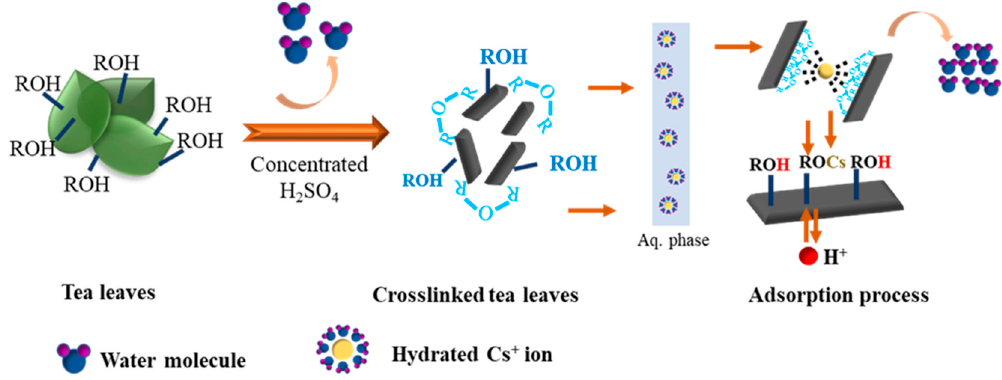
Scheme 1. Modification of tea leaves and Cs adsorption process in the aqueous phase.